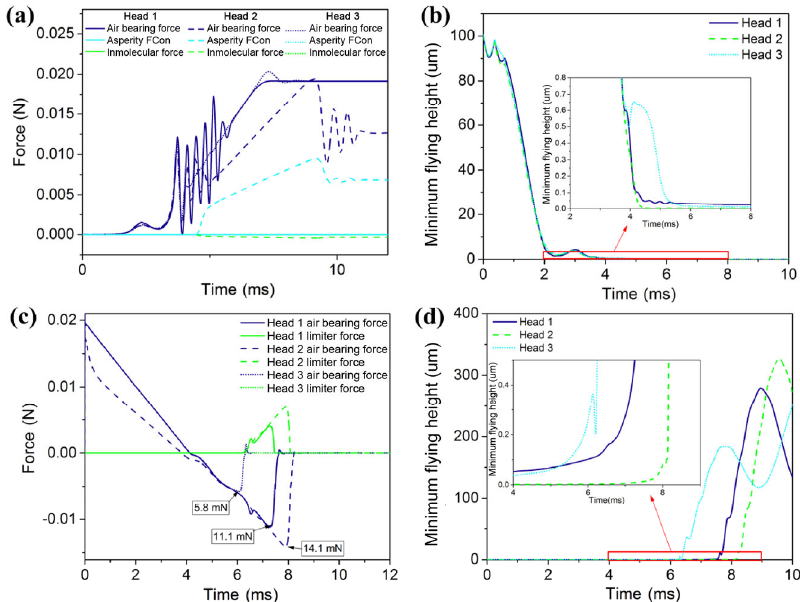
Fig. 10 Load/unload process with different ABS designs: (a) force history and (b) minimum flying height during the load process, (c) force history and (d) minimum flying height during the unload